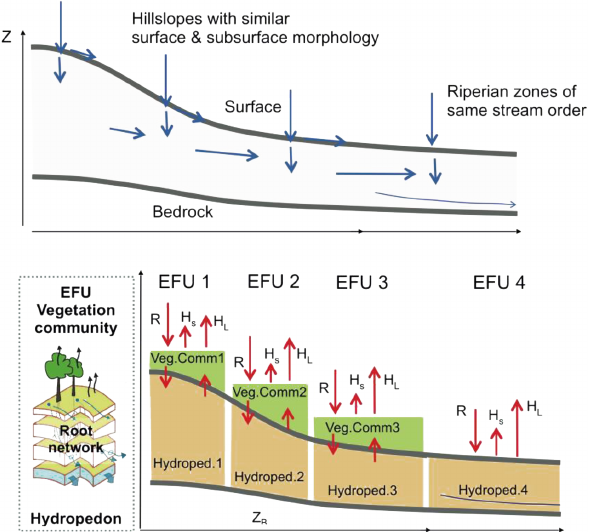
Figure 2. Scheme of lateral topological units and embedded el- ementary functional units controlling rainfall runoff response and land atmosphere energy